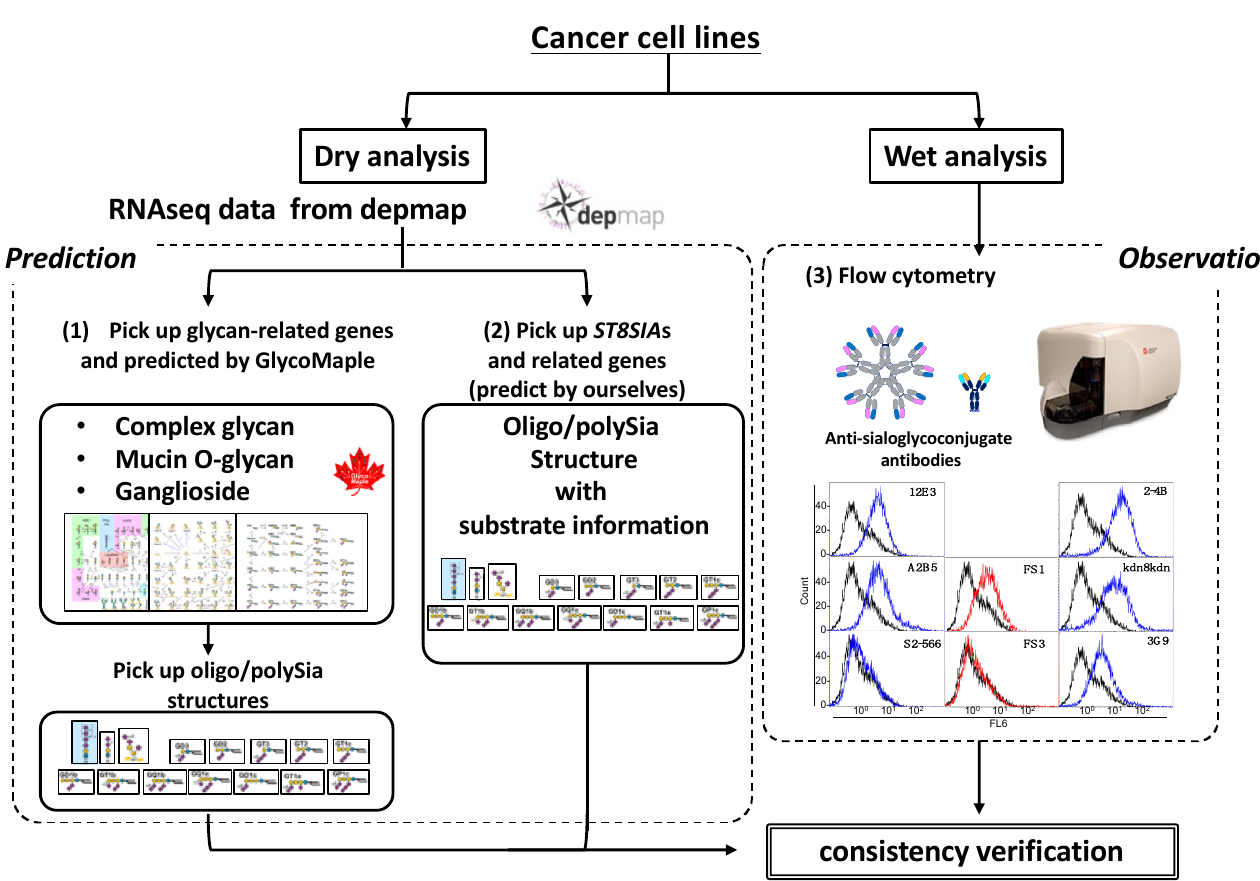
Figure 1. The strategy scheme of this study. For dry analysis, RNAseq data were used to predict oligo/polySia structures by picking up ( 1 ) glycan-related genes followed by the GlycoMaple and ( 2 ) ST8Sias and the related genes followed by our own method. For wet analysis, ( 3 ) flow cytometric analysis of the same cell lines used in dry analysis was performed. Based on the results, the consistencies of the observed and predicted sialoglycoconjugates were verified.